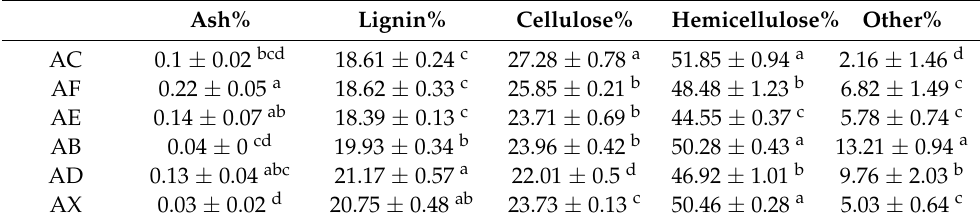
Figure 1. Contents of sugar with different molecular weights ( A ) and contents of soluble solids ( B ) in APL after fungal biomodification. Polysaccharides of different molecular weights were graded through a 200D dialysis bag. AC (none-modified APL); AF ( C. echinulate FR3-modified APL); AB ( P. ostreatus BP3-modified APL); AE ( G. lucidum EN2-modified APL); AD ( S. commune DS1-modified APL); AX ( Xylariaceae sp. XY-modified APL). For the comparison between different biological modifications, different lowercase letters represent significant differences ( p < 0.05). Table 1. Soluble solids components of unmodified and biomodified APL.